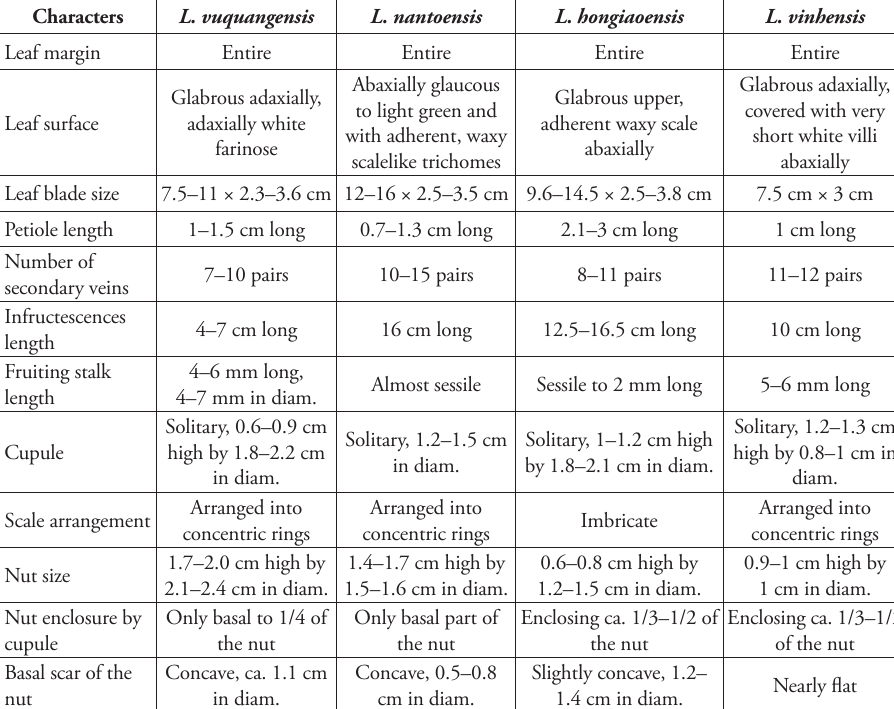
Table 2. Morphological comparison of Lithocarpus vuquangensis with three related species: The measure- ments of L. nantoensis is derived from Hayata (1911), Liao (1996), Huang et al. (1999) and from digitised type specimen image ( Kawakami & Mori 1157 , TI); The measurements of L. vinhensis and L. hongiaoensis are derived from Camus (1948) and Ngoc et al. (in review),